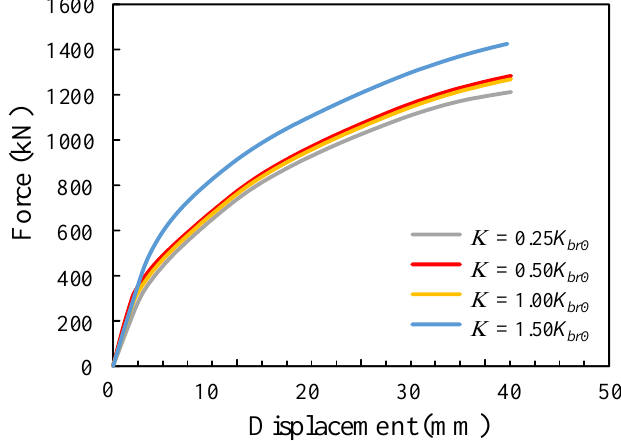
Figure 27. Load–displacement curves for different K br Figure 27. Load – displacement curves for different K br values. Table 8. Comparison of mechanical properties for different K br values.